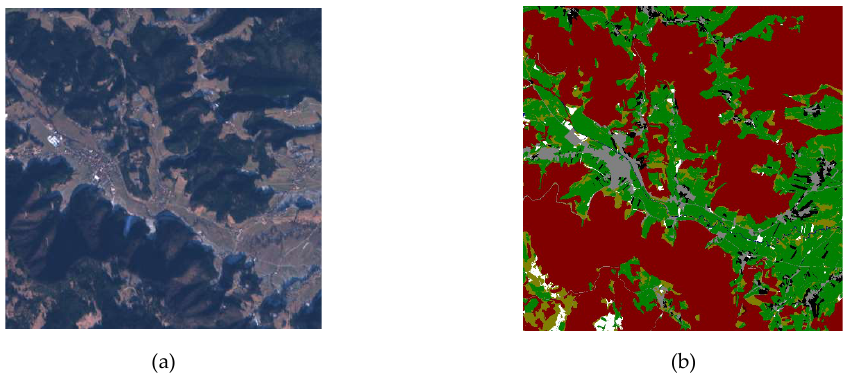
Figure 2. Sample image from Slovenia dataset and its annotation. ( a ) Color image (eopatch-10 × 4_21); ( b ) ground truth mask (eopatch-10 × 4_21).